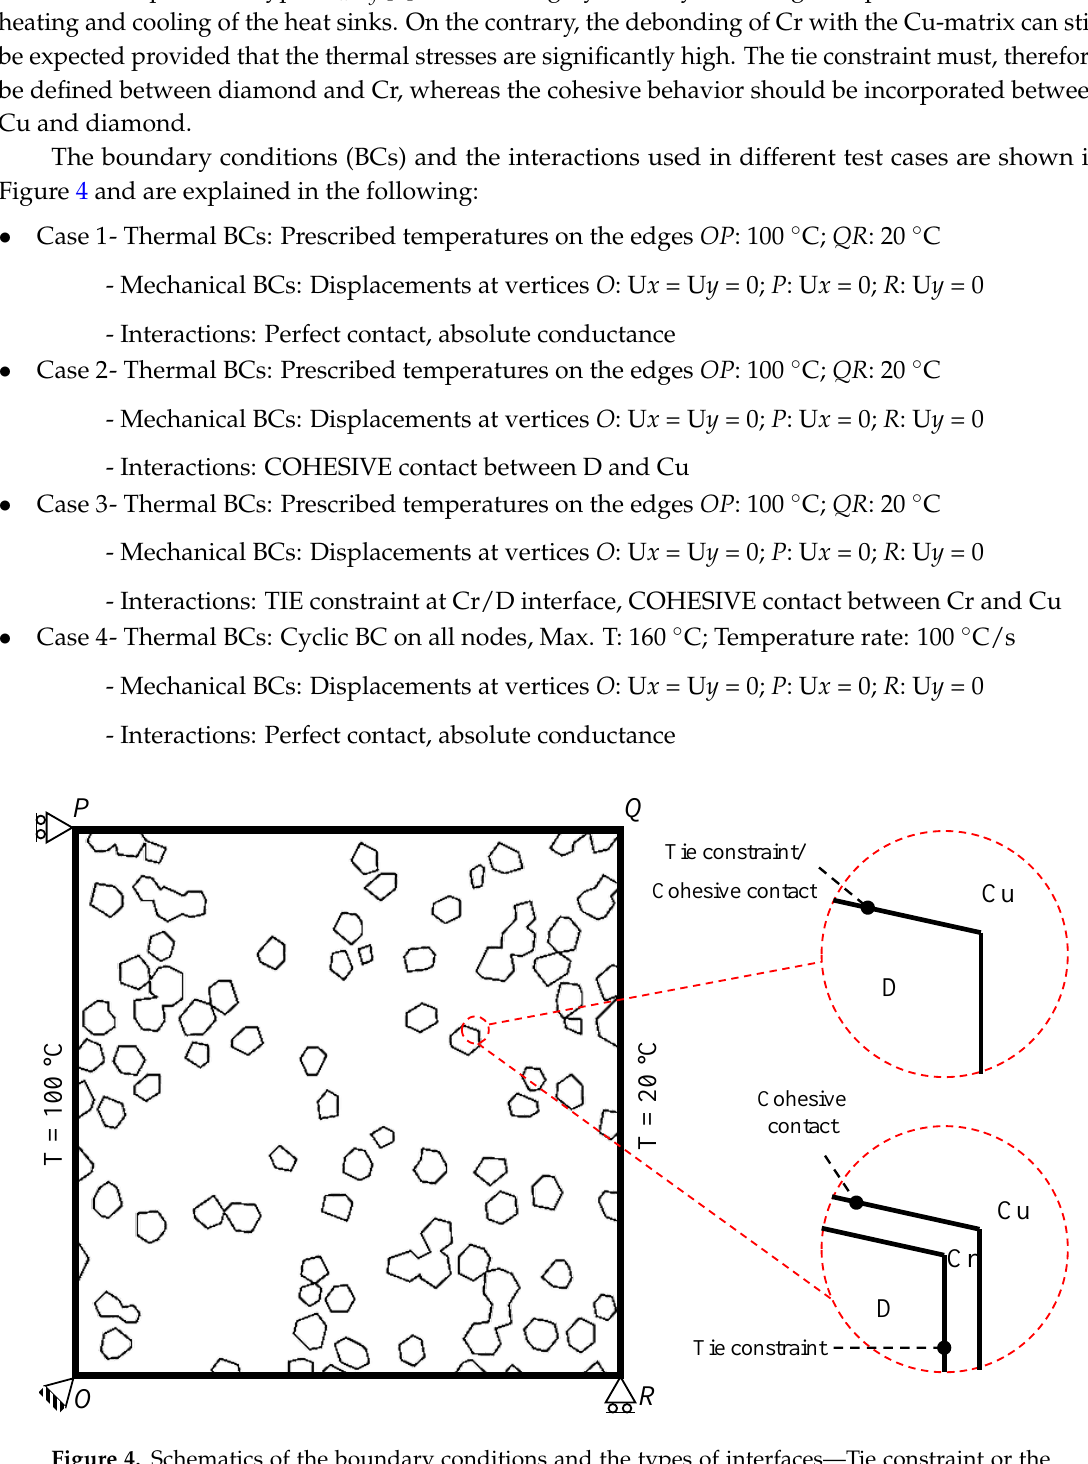
Figure 4. Schematics of the boundary conditions and the types of interfaces—Tie constraint or the cohesive contact at the Cu/uncoated diamond interface, tie constraint at the Cr/diamond interface, and cohesive contact at the Cu/Cr interface.